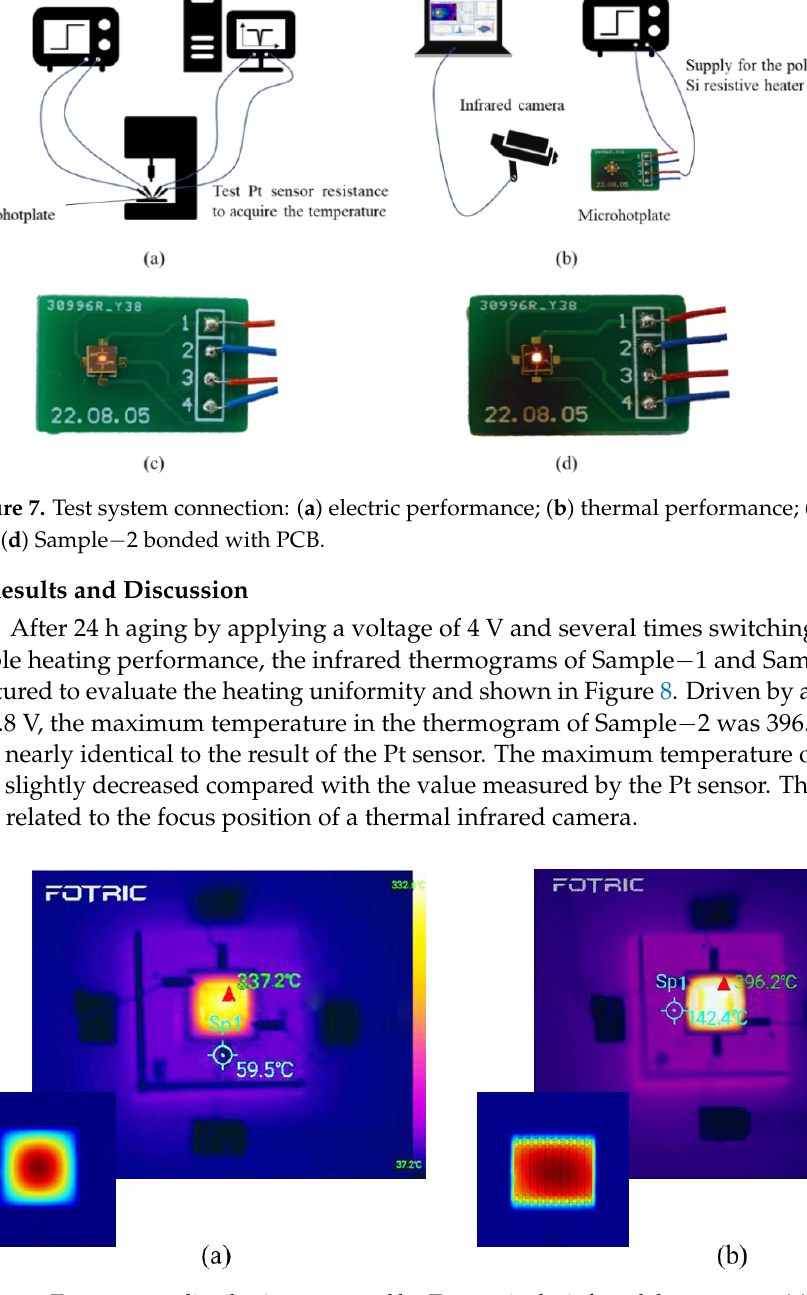
Figure 8. Temperature distribution measured by T 90 area in the infrared thermogram: ( a ) conventional planar poly-Si microhotplate; ( b ) poly-Si microhotplate with compensation structure.